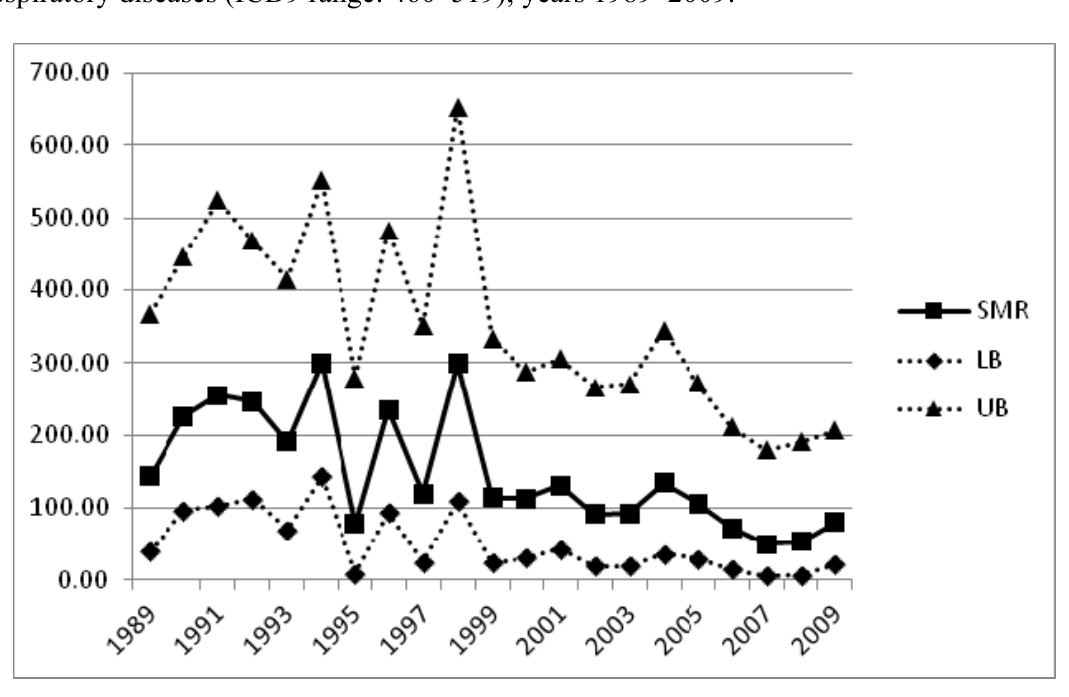
Figure 2. SMRs (with 95% CI) of Milos compared to Cyclades prefecture for the total of respiratory diseases (ICD9 range: 460–519); years